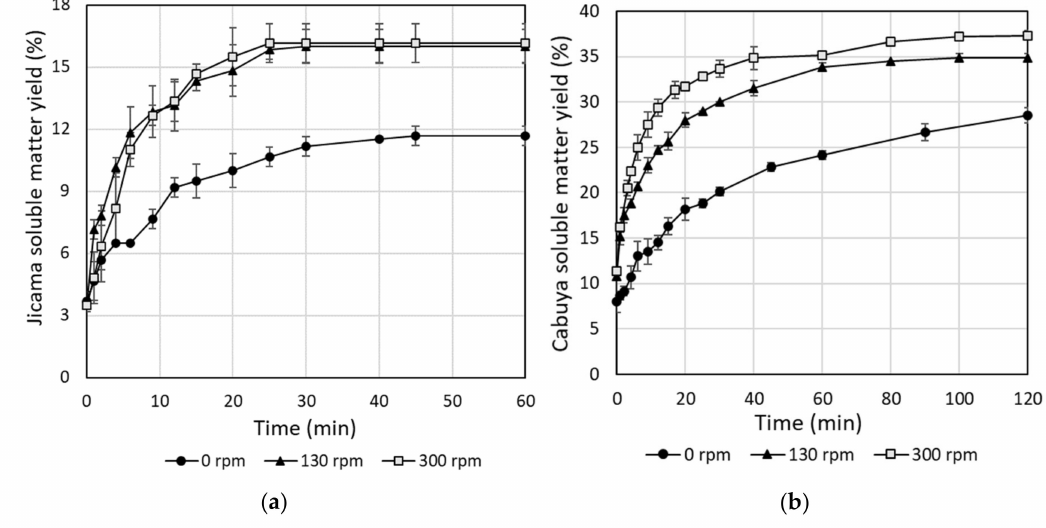
Figure 2. Variation of soluble matter yield as function of extraction time for: ( a ) Jicama roots; and ( b ) Cabuya meristem. Extraction conditions: temperature = 80 ◦ C; solid:liquid ratio =